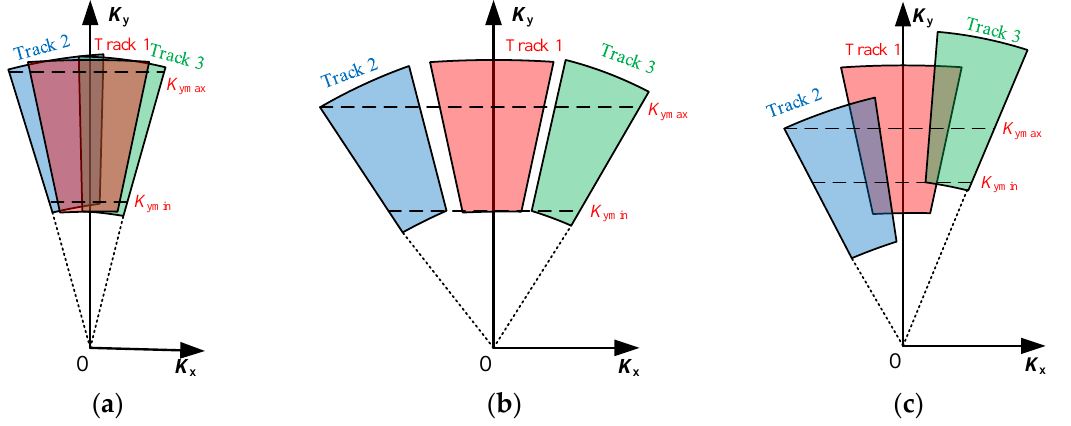
Figure 8. Wavenumber spectrums with ( a ) too much overlapping; ( b ) gaps; and ( c ) too narrow range wavenumber bandwidth.